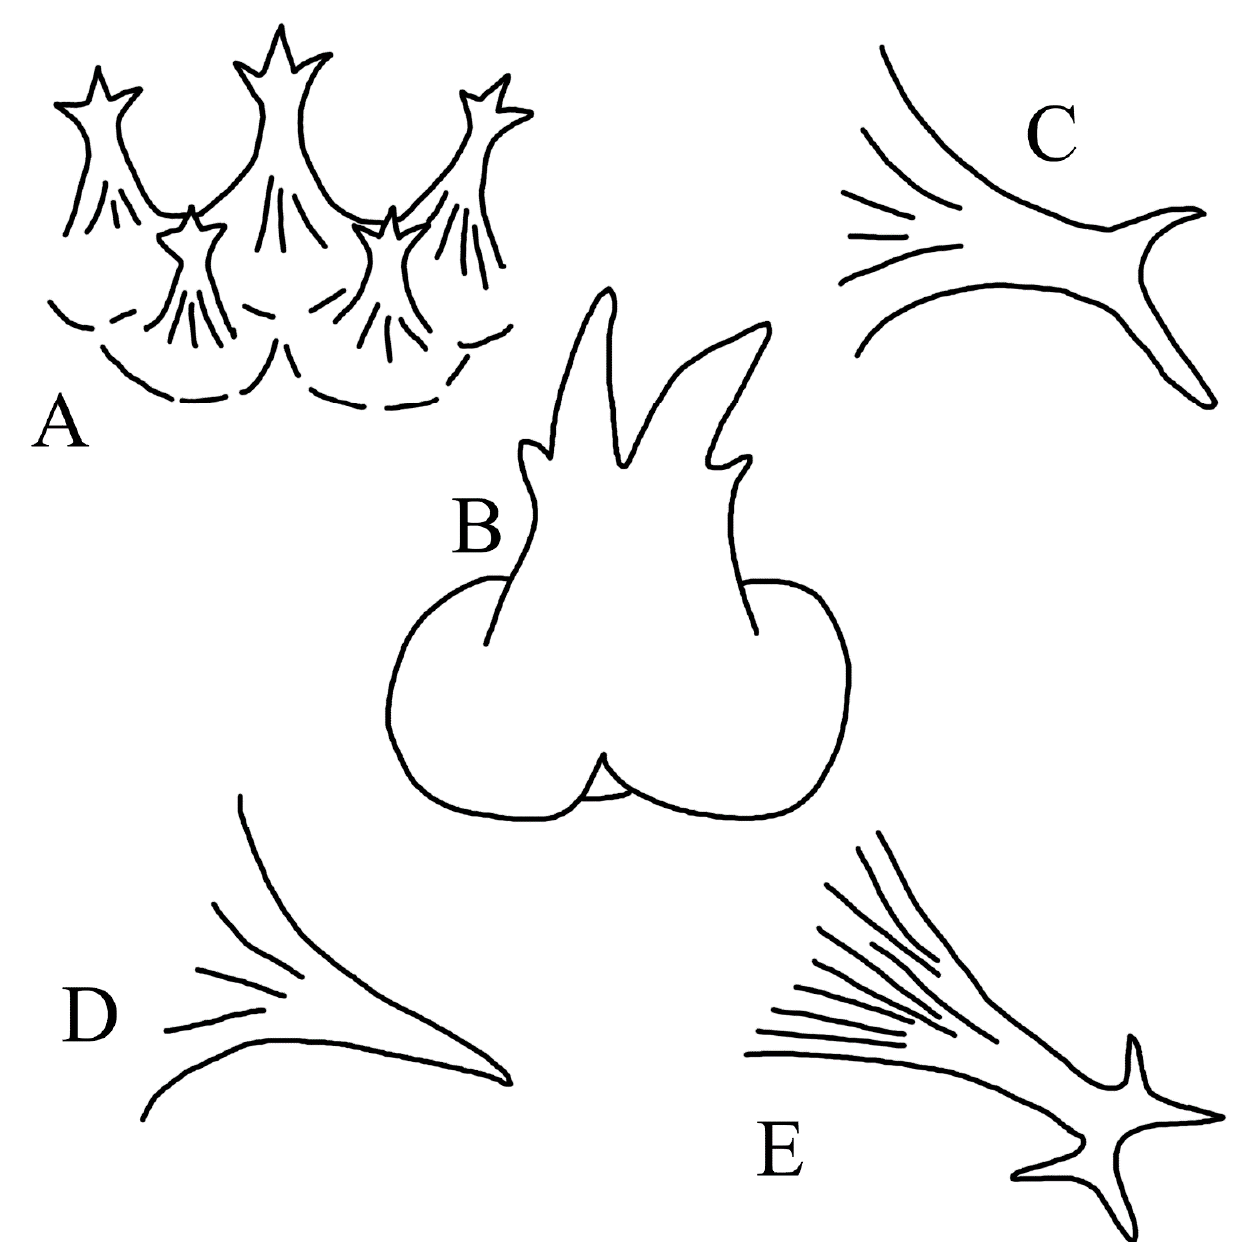
Figure 19. Esca and squamation of H. murrayi sp. November, from holotype. ( A ). Rostral tubercles. ( B ). Esca. ( C ). Tubercle on disk margin. ( D ). Tubercle on tail. ( E ). Subopercular tubercle. ( C ). Tubercle on disk margin. ( D ). Tubercle on tail. ( E ). Subopercular